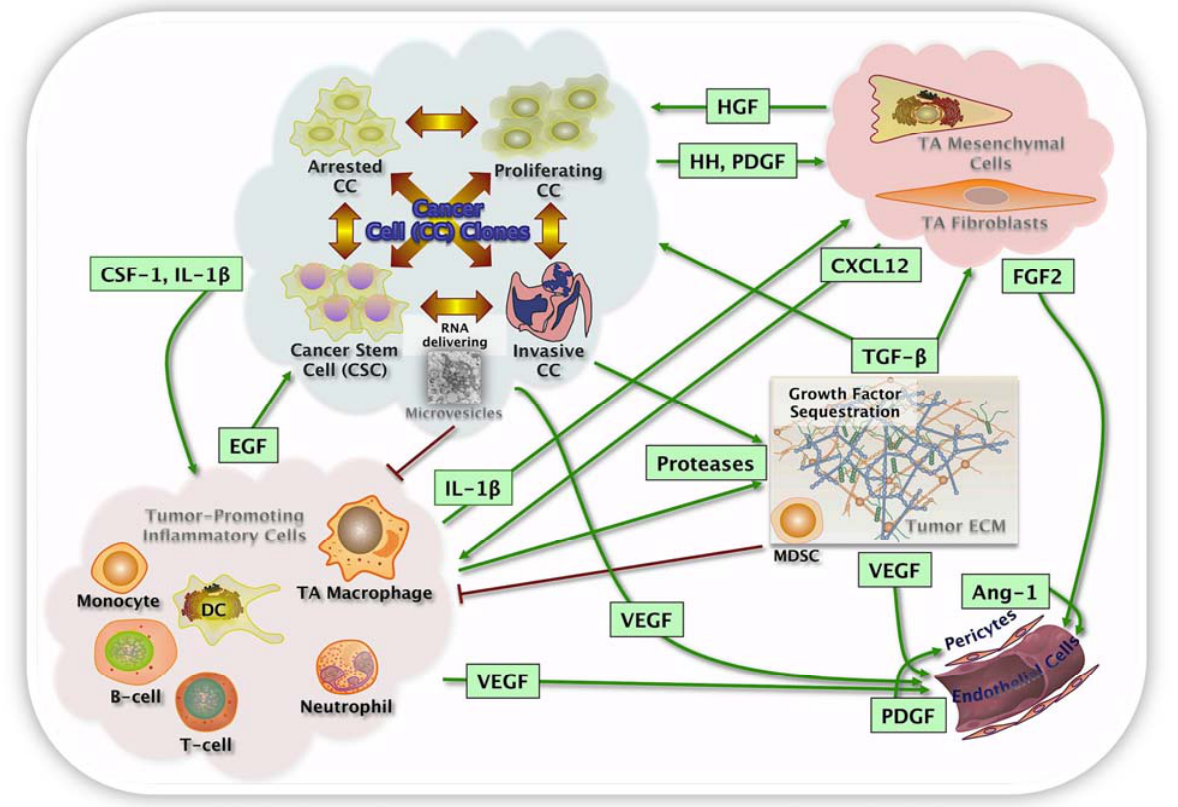
Figure 2. Heterotypic cell biology of tumors and microenvironment. Distinct cell types constitute most solid tumors for both tumor parenchyma and stroma that collectively enable tumor growth and progression. Cancer cells (CC) comprise clones with differential capabilities for kinetics (proliferating and arrested CC), invasiveness (invasive CC) and stemness features (cancer stem cells, CSC). Tumor stroma includes tumor associated mesenchymal cells and fibroblasts, tumor-promoting inflammatory cells, marrow-derived suppressor cells (MDSC) and the vascular component (endothelial cells and pericytes). The multiple stromal cell types create a succession of tumor microenvironments that change as tumors invade normal tissue and thereafter seed and colonize distant tissues. The abundance, histologic organization, and phenotypic characteristics of the stromal cell types, as well as of the extracellular matrix (ECM), evolve during progression, thereby enabling primary, invasive, and then metastatic growth. The assembly and collective contributions of the assorted cell types constituting the tumor microenvironment are orchestrated and maintained by reciprocal heterotypic signaling interactions, of which only a few are illustrated. The signaling depicted within the tumor microenvironment is not static but instead changes during tumor progression as a result of reciprocal signaling interactions between cancer cells and stromal cells that convey the increasingly aggressive phenotypes that underlie growth, dormancy, invasion, and metastatic dissemination. Importantly, the predisposition to spawn metastatic lesions can begin early, being influenced by the differentiation program of the normal cell-of-origin or by initiating oncogenic lesions. Cancer stem cells may be variably involved in some or all of the different stages of primary tumorigenesis and